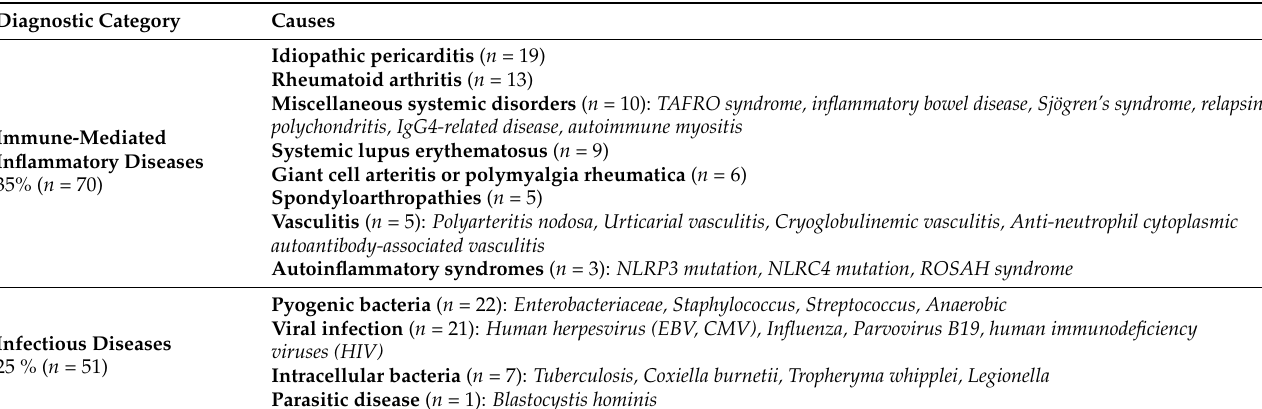
Table 2. The distribution of diagnoses in control